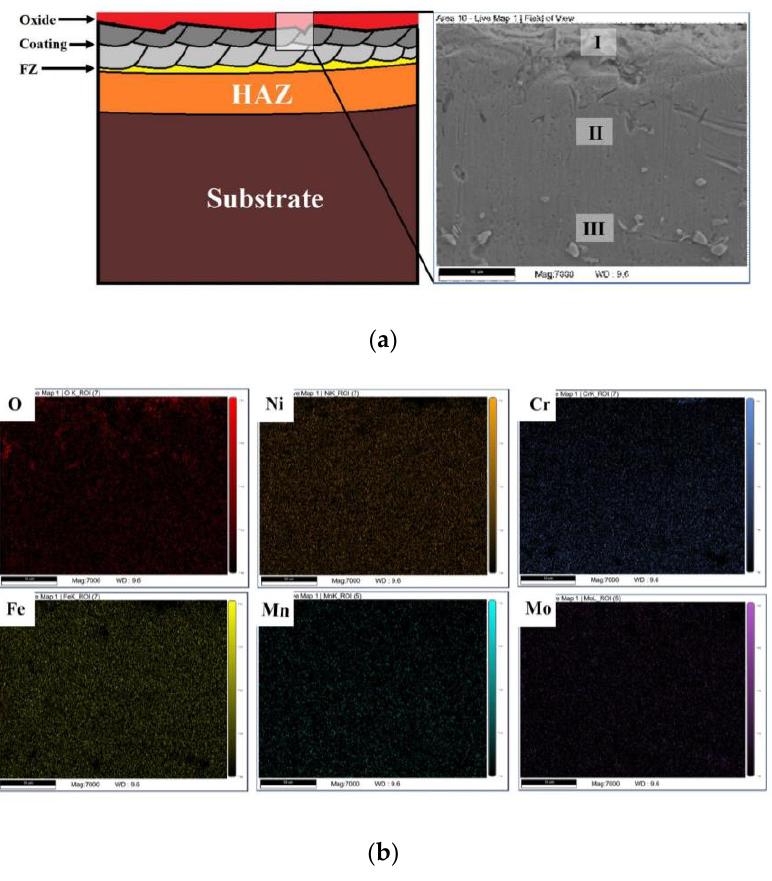
Figure 10. SEM ( a ) and EDS mapping result ( b ) of Sample 1600-10 after high-temperature oxidation treatment.